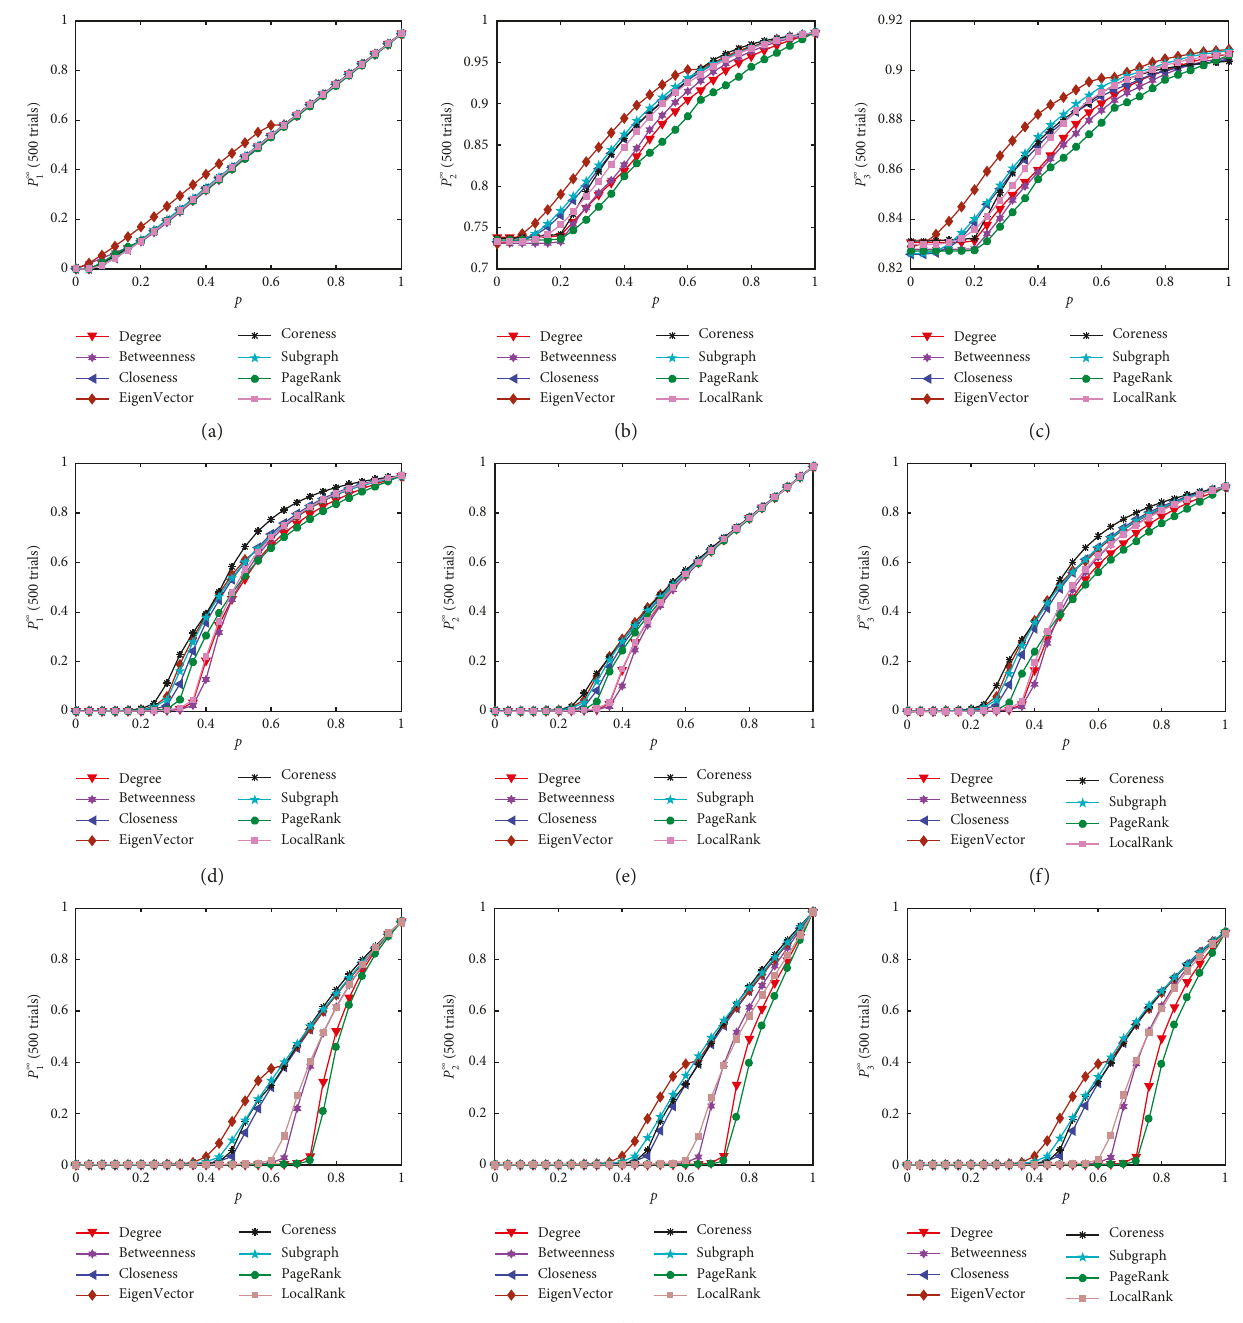
Figure 7: Model M1-based robustness of tripartite network G G V that also belong to the LCC, are drawn with respect to different values of p. (a–c) the case where the node attacks occur to V i ⊂ 1 the case where the node attacks occur to V